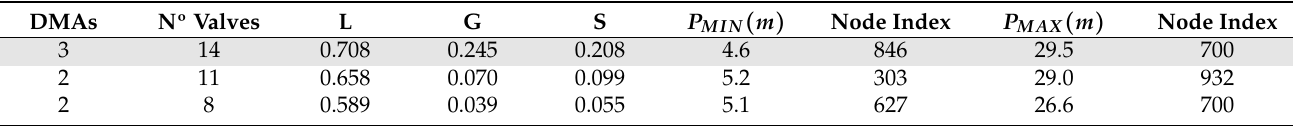
Figure 10. DMAs obtained for MLN network. Solutions A, B and C are those indicated in Figure 9 for ( a ) Standard deviation, ( b ) Gini coefficient and ( c ) Loss of resilience. Table 4. Operating conditions of each solution obtained with Standard deviation for MLN network. The gray background corresponds to the solution A represented in Figure 10.